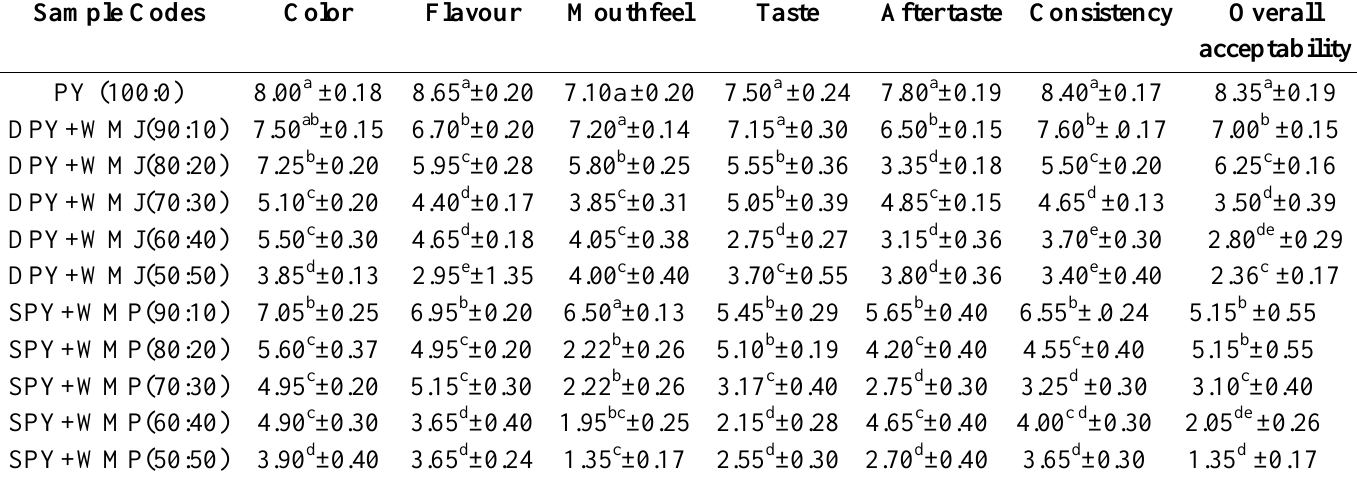
Table 4: Sensory scores of yoghurt flavored with graded levels of watermelon pulp and juice. Sample